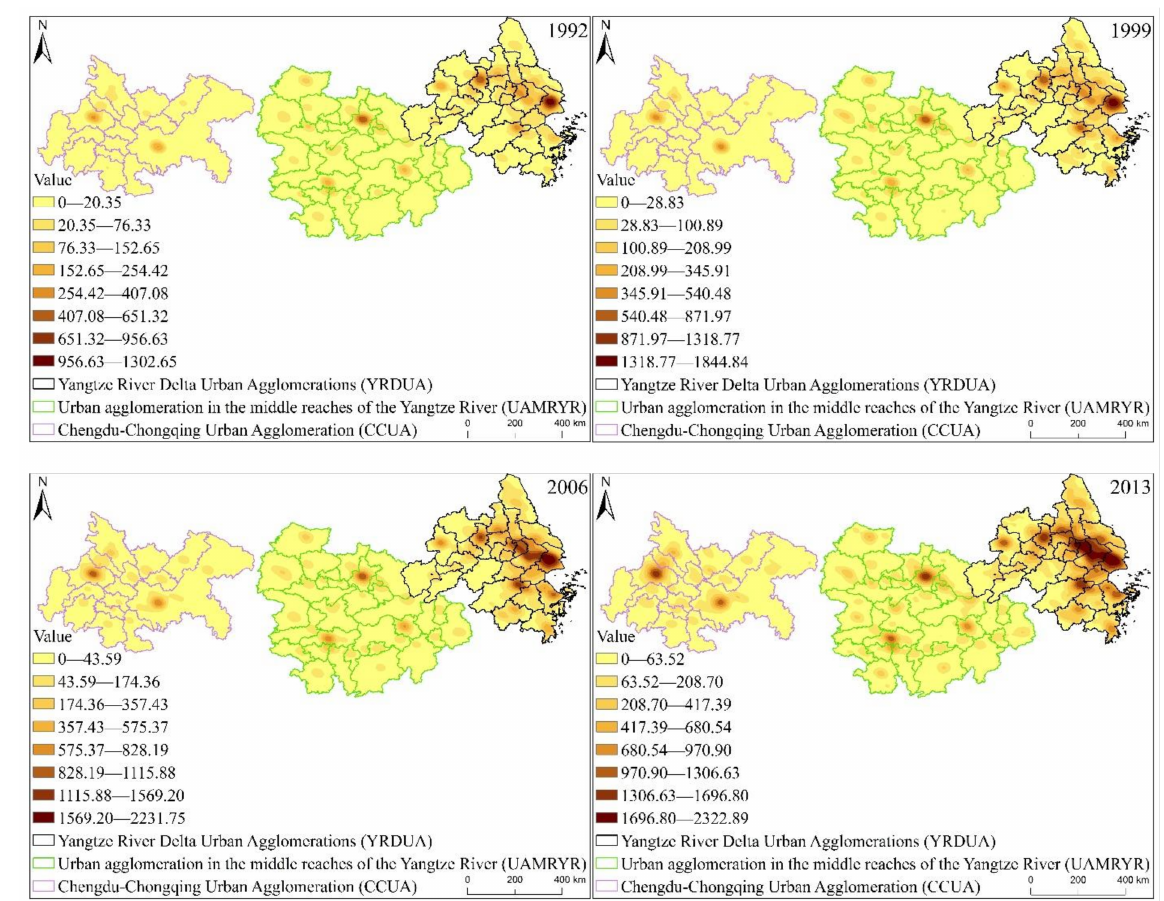
Figure 6. EPC kernel density distribution of the three major urban agglomerations of YREB from 1992 to